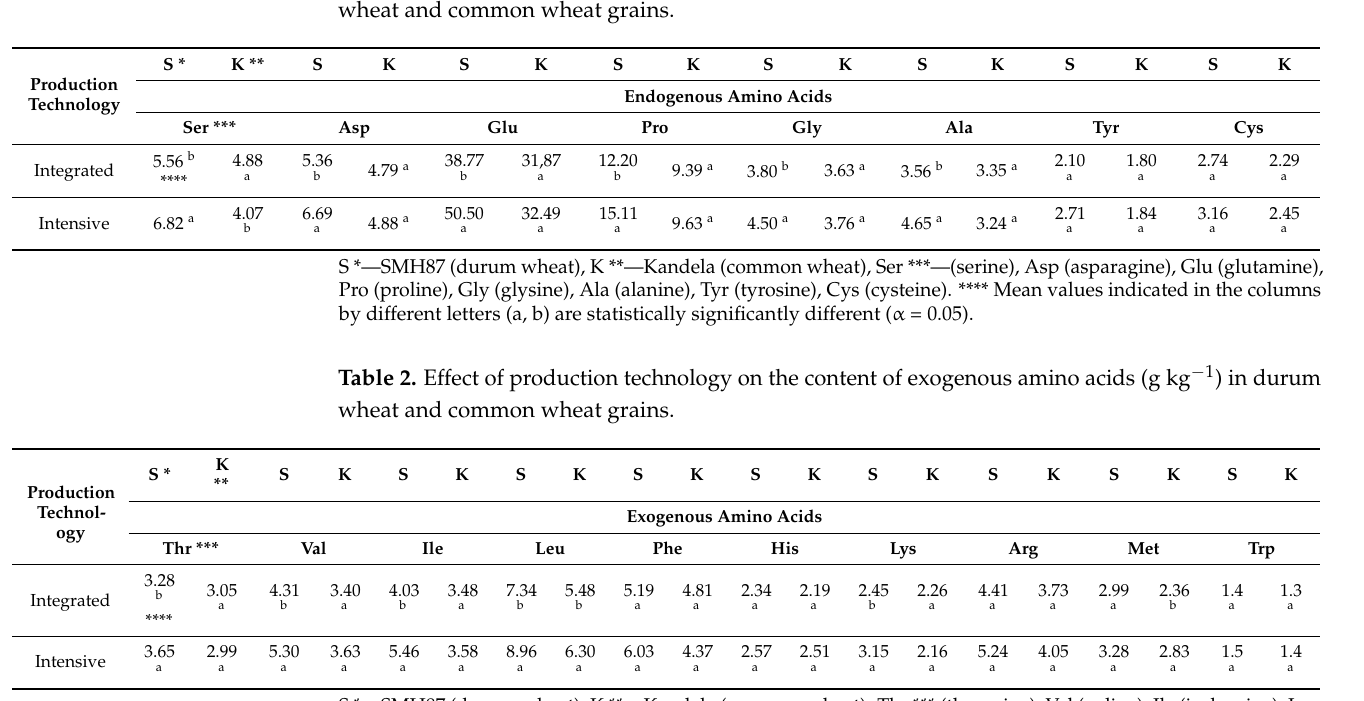
Table 1. Effect of production technology on the content of endogenous amino acids (g kg − 1 ) in durum wheat and common wheat grains.